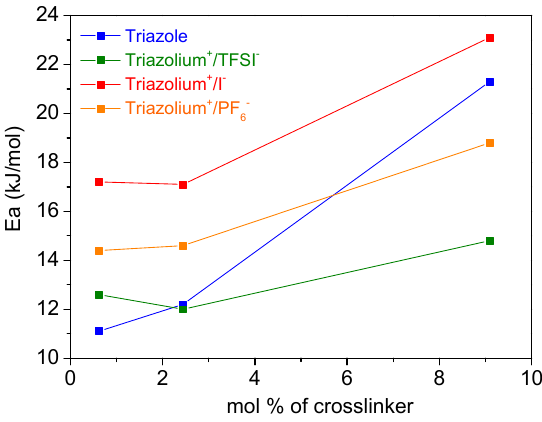
Figure 9. The plot of activation energy ( E a ) versus crosslinker concentration (in mol %).